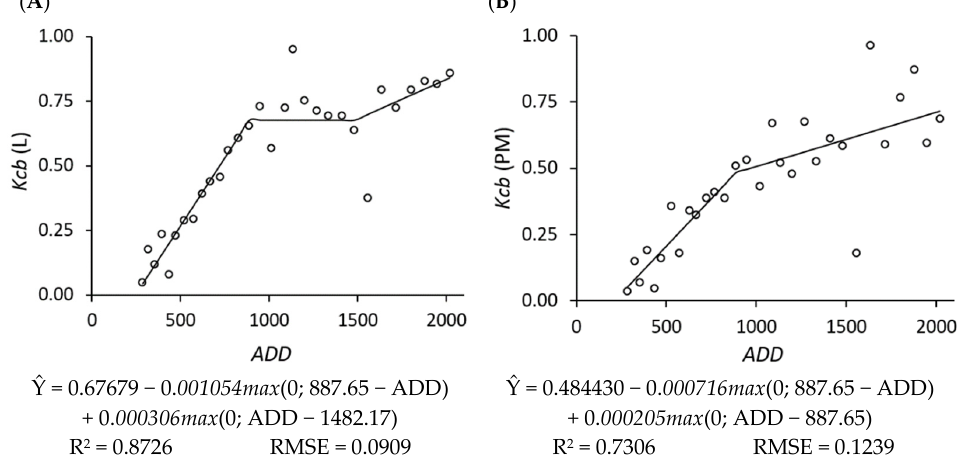
Figure 3. Basal crop coefficient (Kcb) of strawberry as a function of accumulated growing degree-days (ADD), after transplanting, using the ( A ) lysimeter (L) and ( B ) Penman–Monteith (PM) methods, with recycled paper mulch.